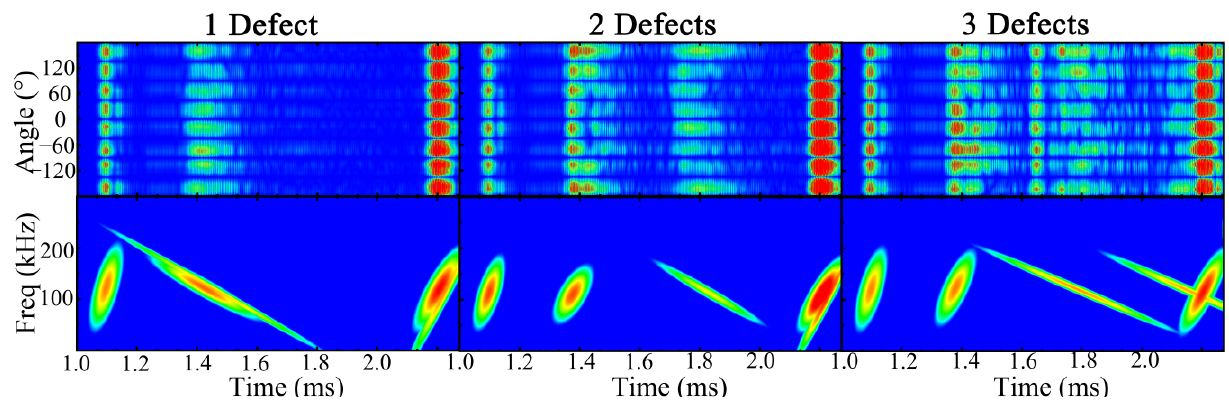
Figure 13. Time–frequency diagrams of simulated UGW signals (axial, circumferential and radial) with multi-defect ( α = 300°).